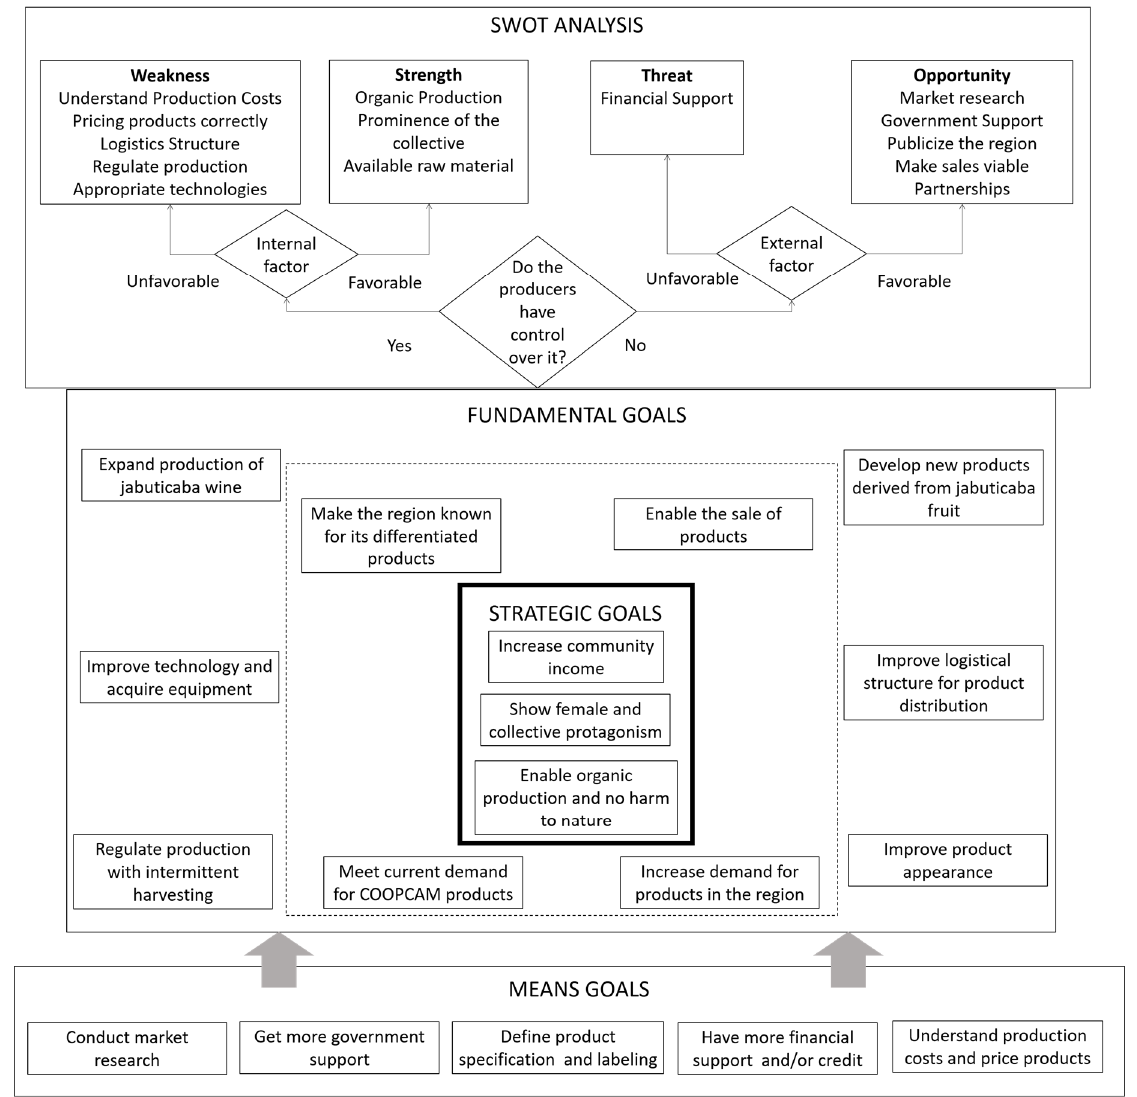
Figure 3. Flowchart of VFT objectives and SWOT analysis.